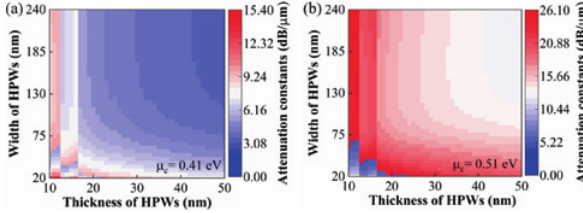
Figure 5: Shifts of (a) α at μ c = 0.41 eV, (b) α at μ c = 0.51 eV with the increase of t 1 and w .